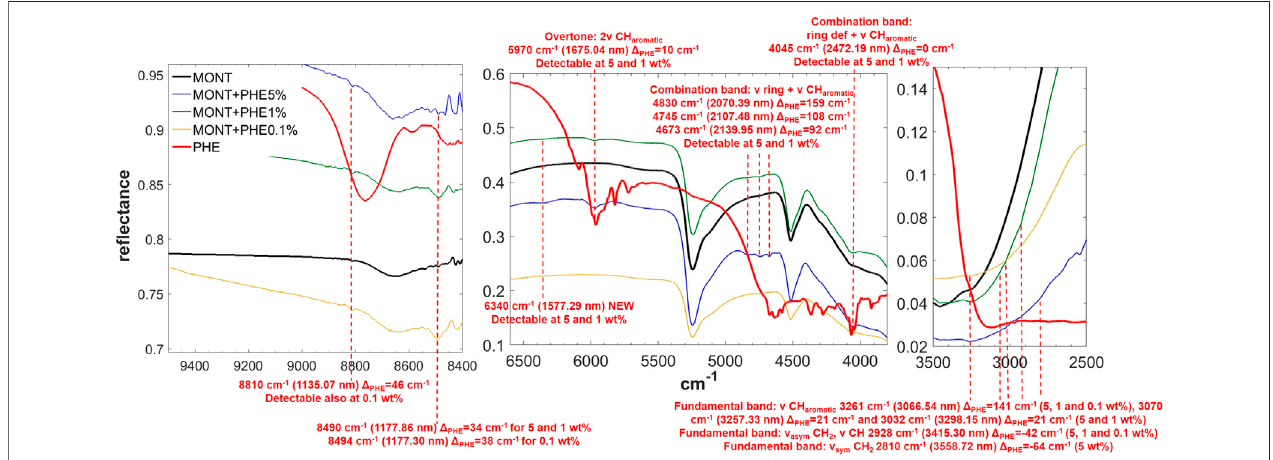
FIGURE5| NIRspectraofPHEadsorbedonmontmorilloniteat5,1,and0.1 wt%concentration.Legend: Δ PHE (cid:2) wavenumbershiftwithrespecttothesamepeak of the pure molecule in the solid state; ν (cid:2) stretching vibrational mode; δ (cid:2) bending vibrational mode; def (cid:2) deformation vibrational mode; sym (cid:2) symmetric vibrational mode; asym (cid:2) asymmetric vibrational mode.